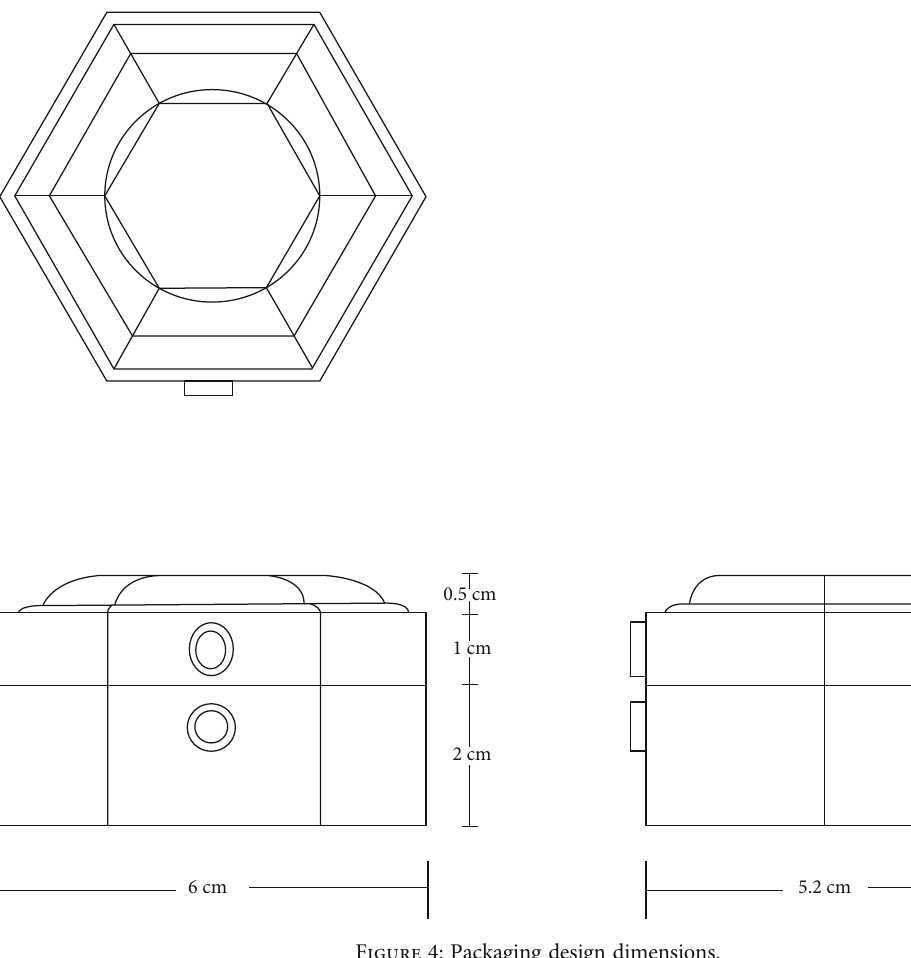
Figure 4: Packaging design